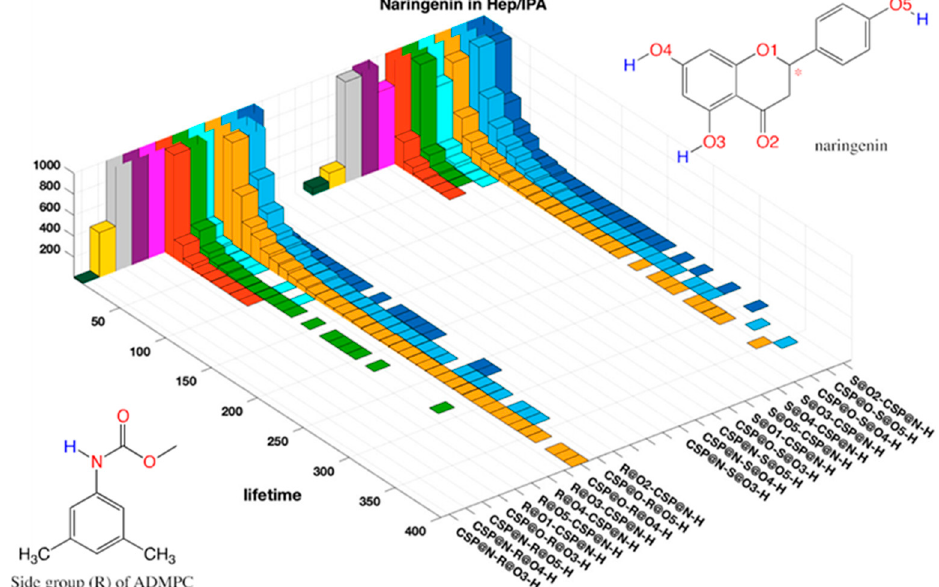
Figure 4. Distribution of lifetimes (ps) of hydrogen bonds between R or S enantiomers of naringenin and ADMPC on silica in heptane/isopropanol 90:10 for each of the acceptor–donor pairs: CSP@O and CSP@N denote the acceptor sites and CSP@N–H denotes the donor site in the chiral stationary phase ADMPC strands. S@O1-5, and R@O1-5 denote the five acceptor sites and S@O3-5H and R@O3-5H denote the three donor sites on the S and R enantiomers of naringenin, respectively. These are the sites identified in top right and bottom left figures for naringenin and ADMPC. The y axis counts the number of incidences over the entire trajectory; the very high counts for the very short lifetimes are cut off in this display. [Adapted with permission from